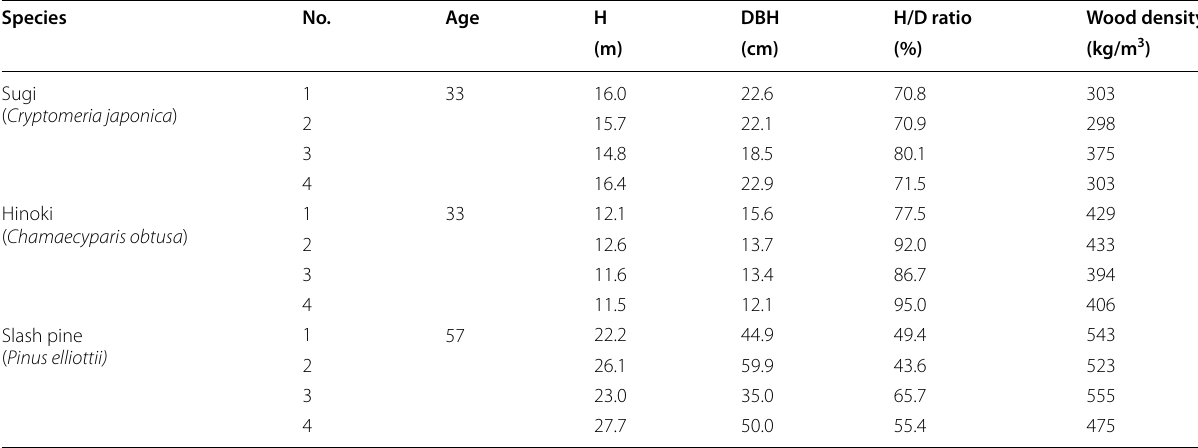
H tree height, DBH diameter at breast height, H/D ratio height-to-diameter ratio The wood density was measured on the samples with 2–4 outer rings (including the current rings being formed in 2011)